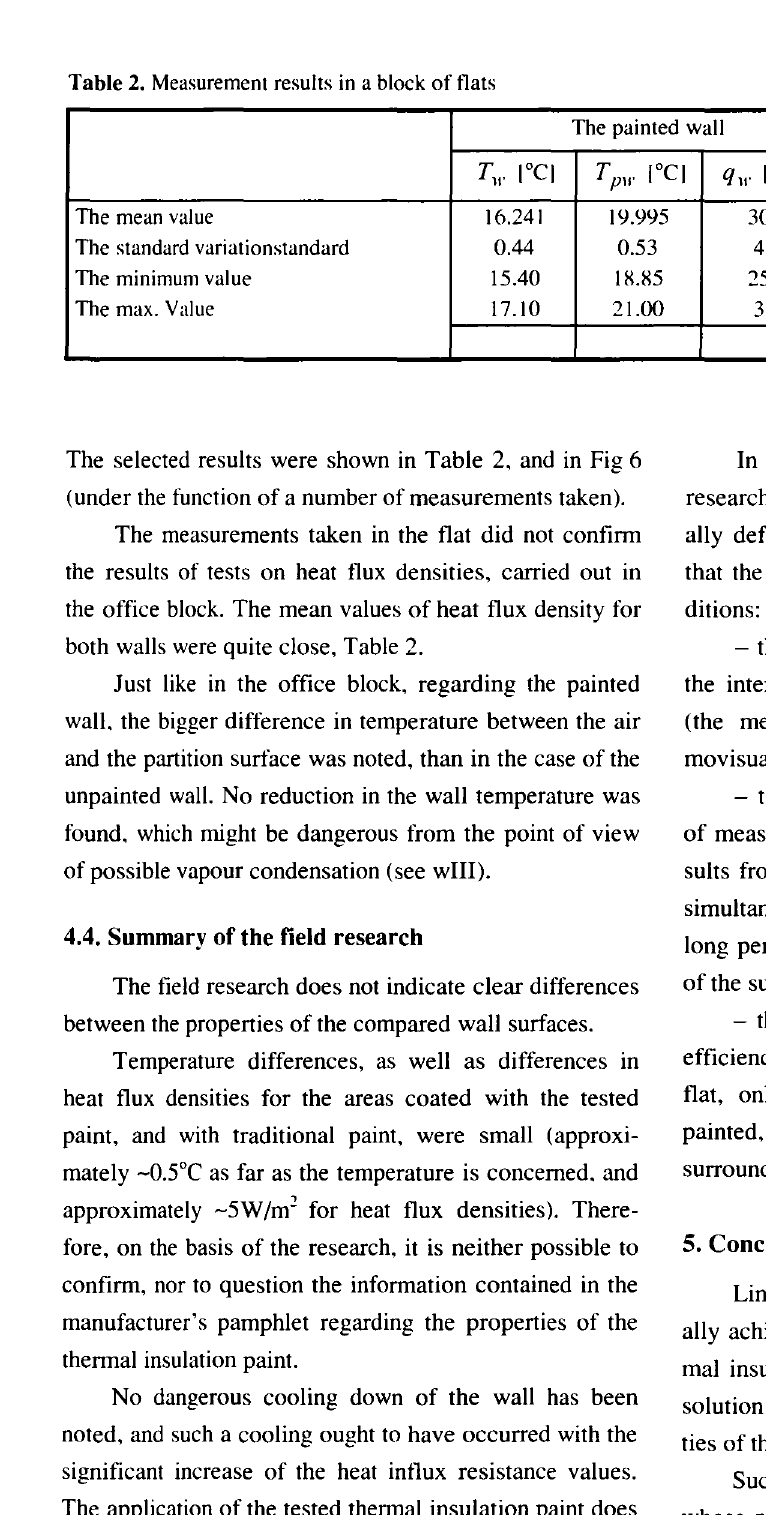
Table 2. Measurement results in a block of flats